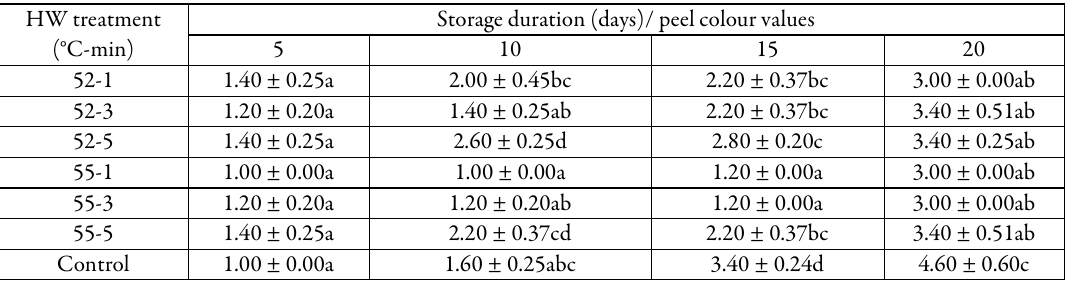
Note: Each value is a mean of 5 replicates and where significant, the means were separated using Duncan multiple range